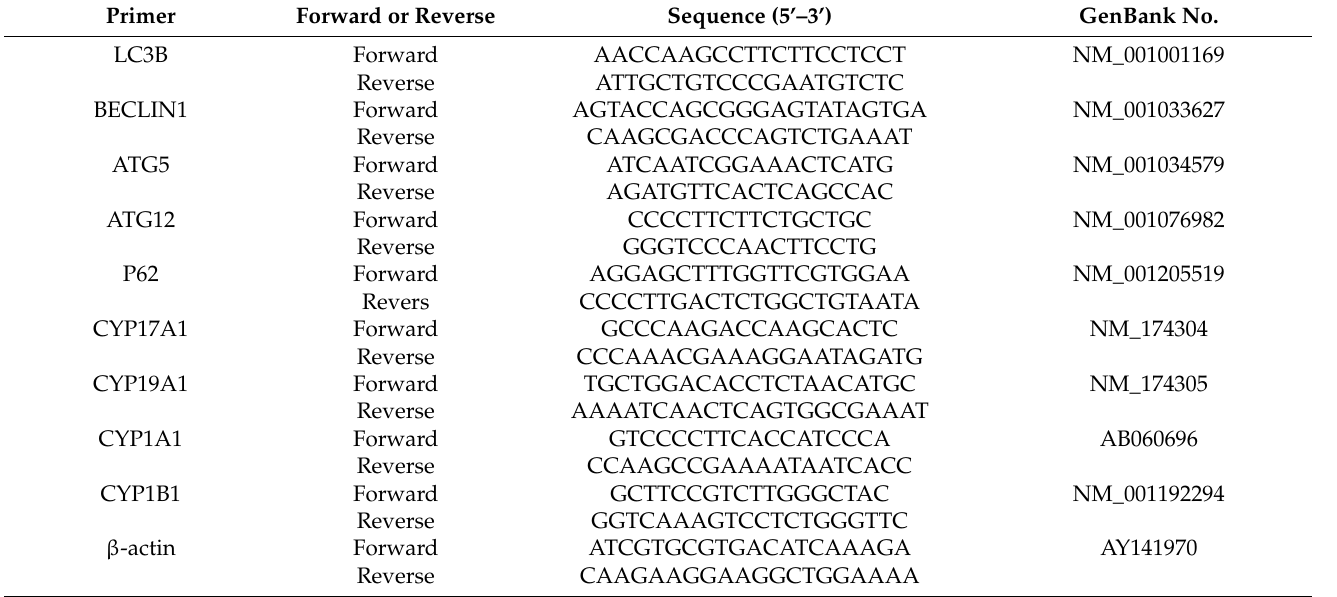
Table 1. RT-qPCR primers used in this